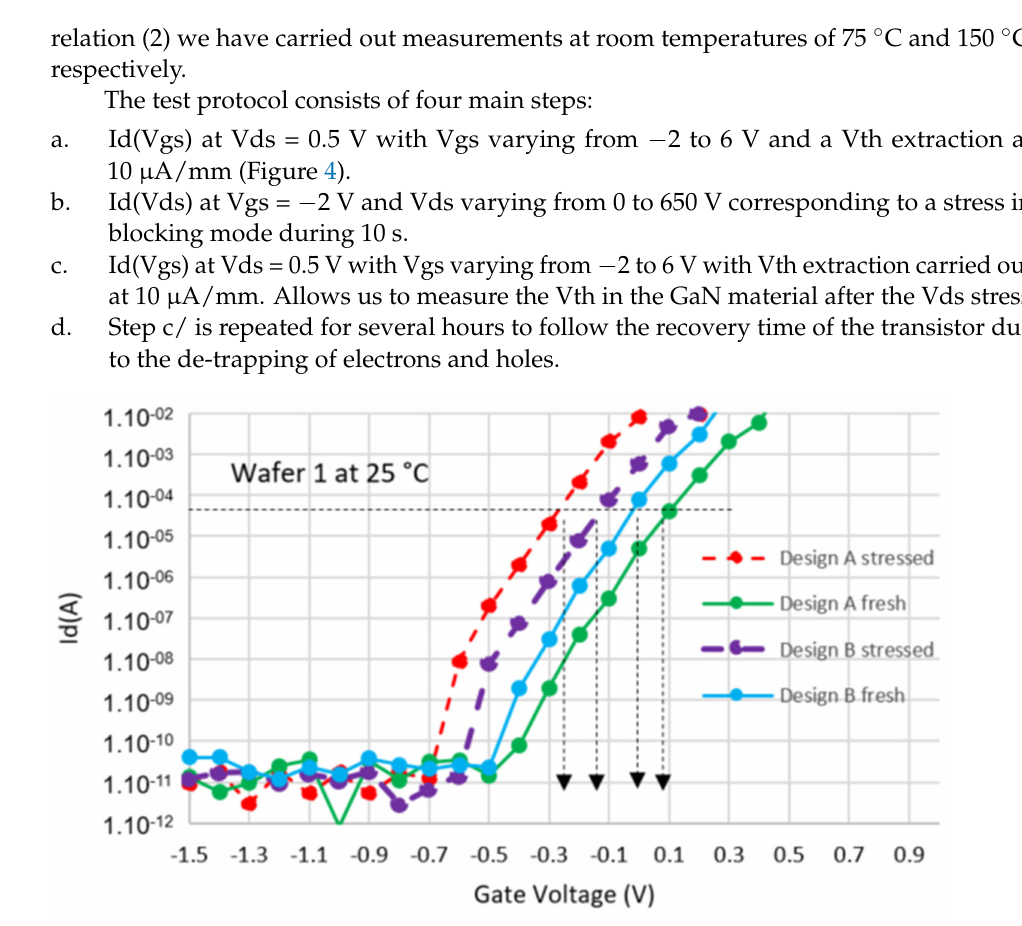
Figure 4. Example of Vth shift for two different devices named design A and design B before and after 650 V stress during 10